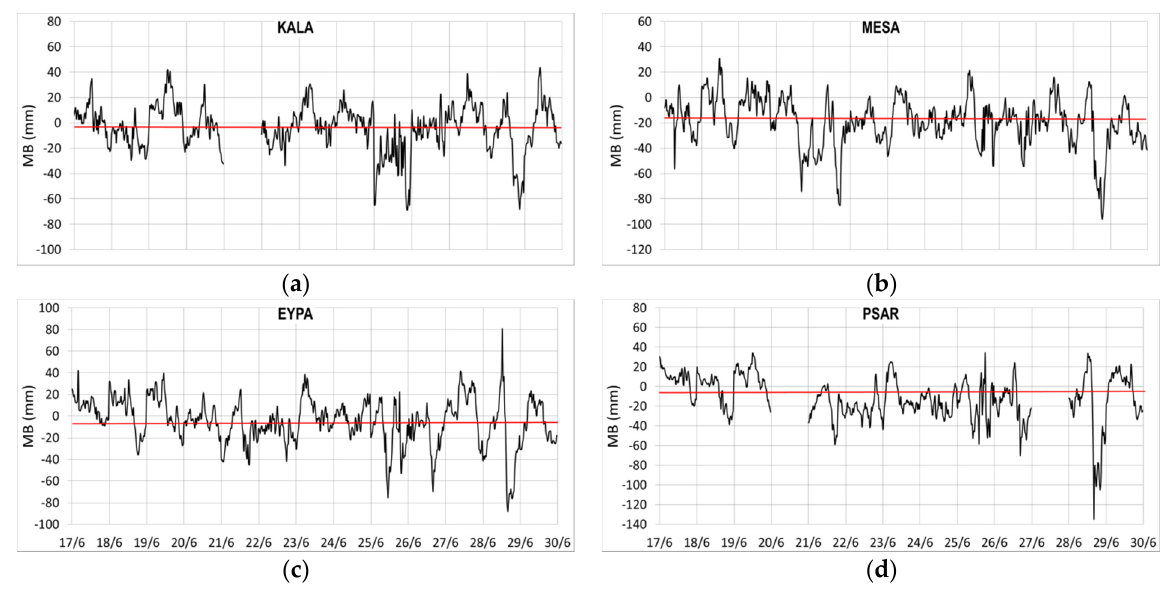
Figure 4. Bias plots of predicted (WRF MOD5) minus observed (GNSS) ZTDs at 4 PaTrop stations, KALA ( a ), MESA ( b ), EYPA ( c ) and PSAR ( d ) over the test period (17–29 June 2016). The red line indicates the mean bias.